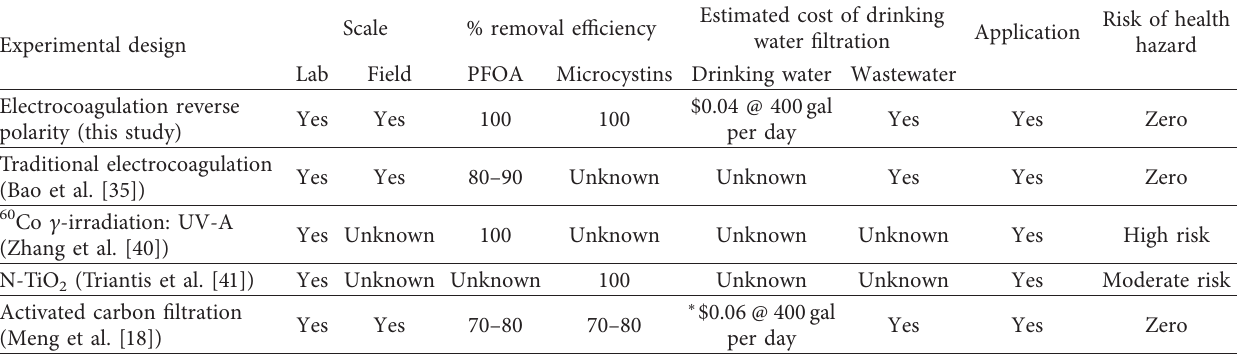
Figure 7: Sample residues (flocculants) from (a) PFOA and (b) microcystins electrocoagulation. Table 3: Technical and economic performance of electrocoagulation reverse polarity (ECRP) technique compared with other published methods for PFOA and microcystin